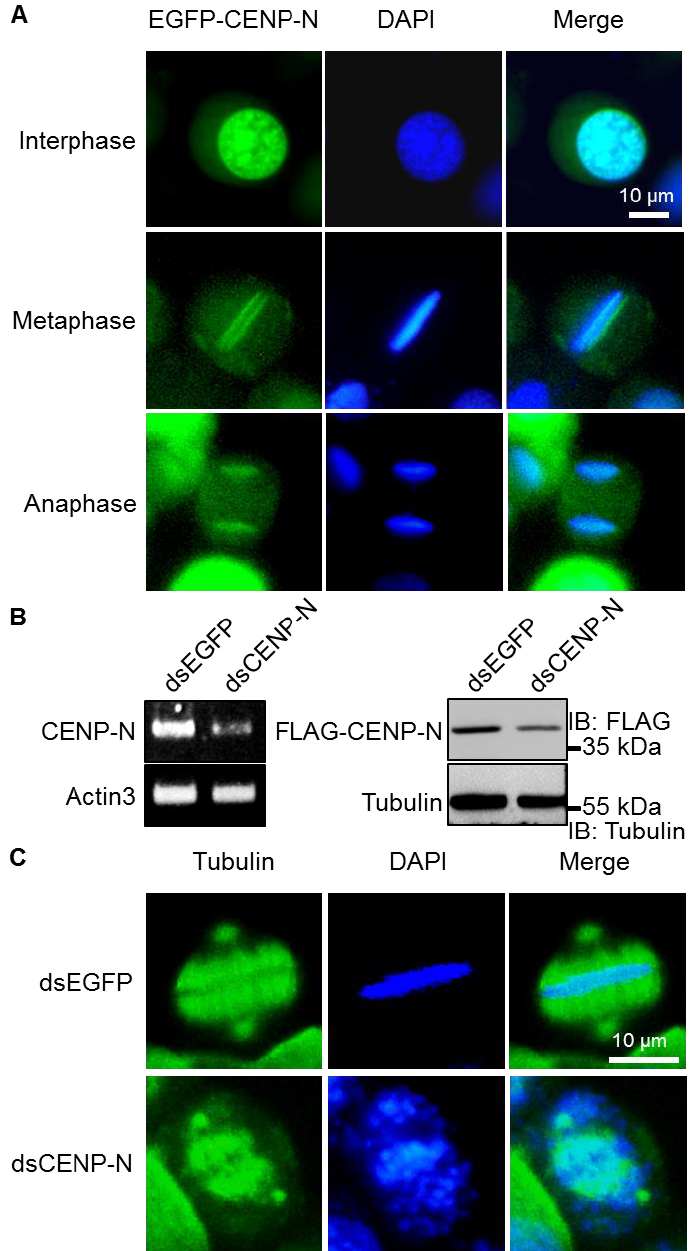
Figure 1. Kinetochore function of CENP-N in silkworms. ( A ) Representative images of silkworm cells expressing EGFP-CENP-N in di ff erent cell cycle phases. CENP-N was labeled with EGFP fluorescence (green) and cell cycle phases were determined by DAPI (blue). Scale bar, 10 µ m. ( B ) RT-PCR and Western blotting assays of RNAi e ffi ciency for CENP-N in cultured silkworm BmN4-SID1 cells stably expressing FLAG-CENP-N. The cells were treated with control dsRNA or CENP-N dsRNA, and the expression of actin3 and tubulin were used as loading controls, respectively. ( C ) Representative immunofluorescence images of mitotic phenotypes following CENP-N knockdown. Cells were fixed and stained with anti-tubulin antibody (red) and the nuclear DNA were stained with DAPI (blue). At least 10 metaphase cells were recorded for CENP-N knockdown. Scale bar, 10 µ